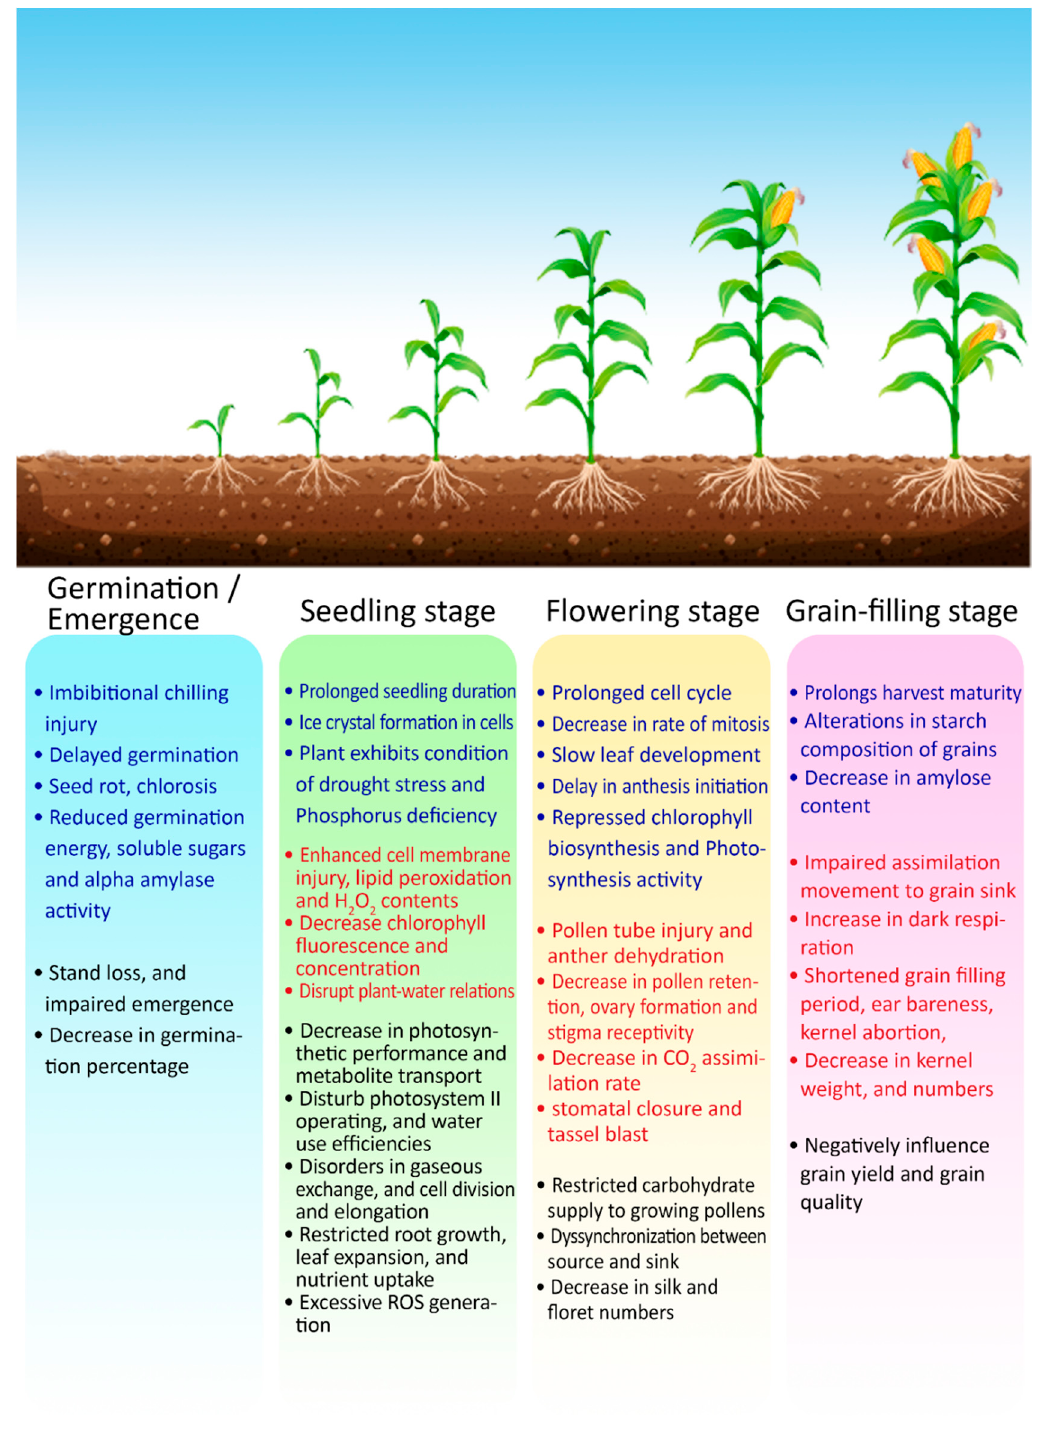
Figure 4. Overview of the impacts of cold and heat stresses on critical growth phases of maize crop. Heat stress impacts are marked by red fonts, while blue fonts indicate impacts of cold stress. Combined impacts (which can be caused by both stresses) are marked by black fonts.